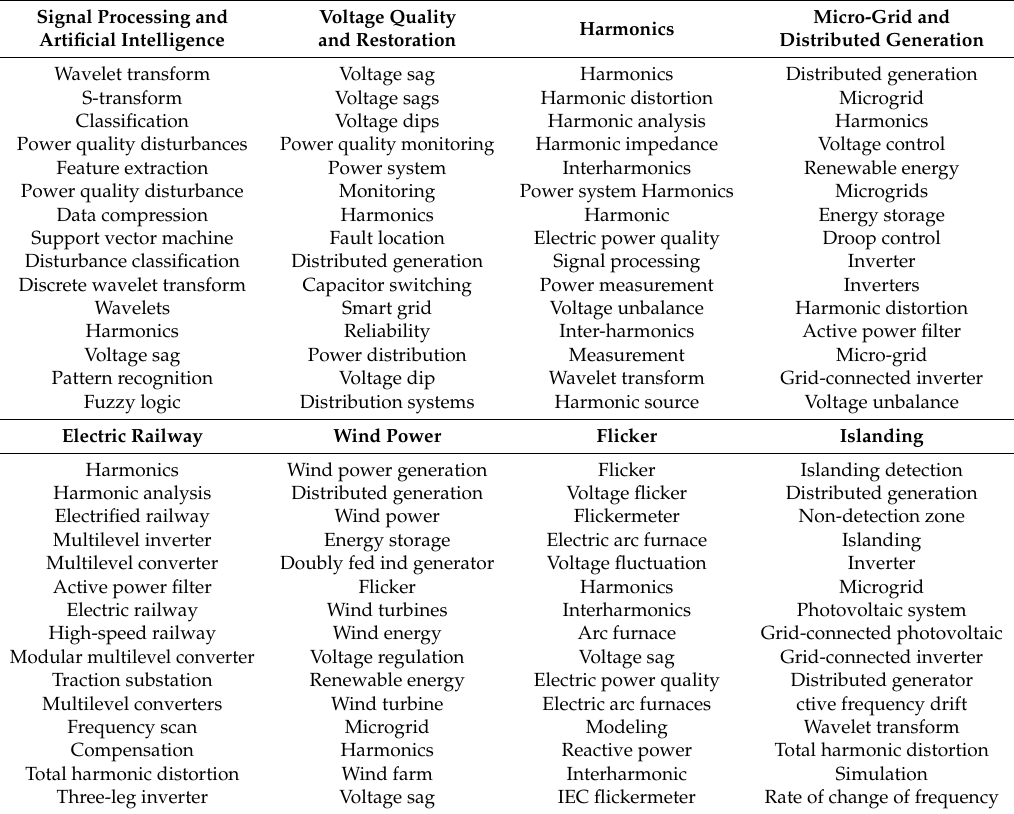
Table 1. Fifteen most used keywords among different communities.